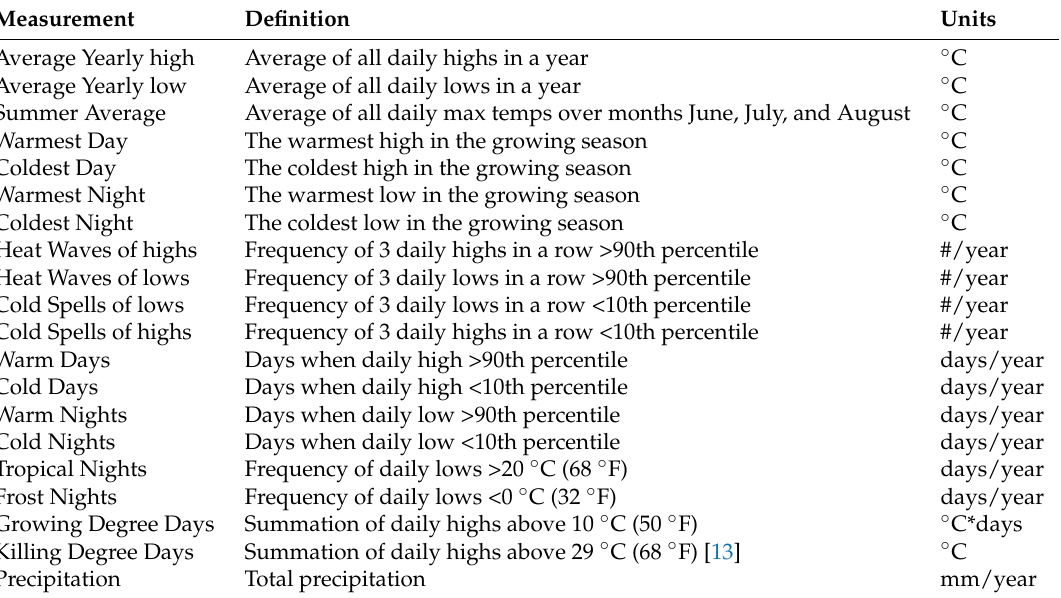
Table 1. Temperature measures computed to find correlations to crop yields. Summer average temperature, heat waves, and killing degree days had the highest correlation, and thus were used as predictors of crop yields. All statistics after the first four are summed over the growing season for each crop and location. Here, highs and lows refer to the recorded daily high and low temperature at each